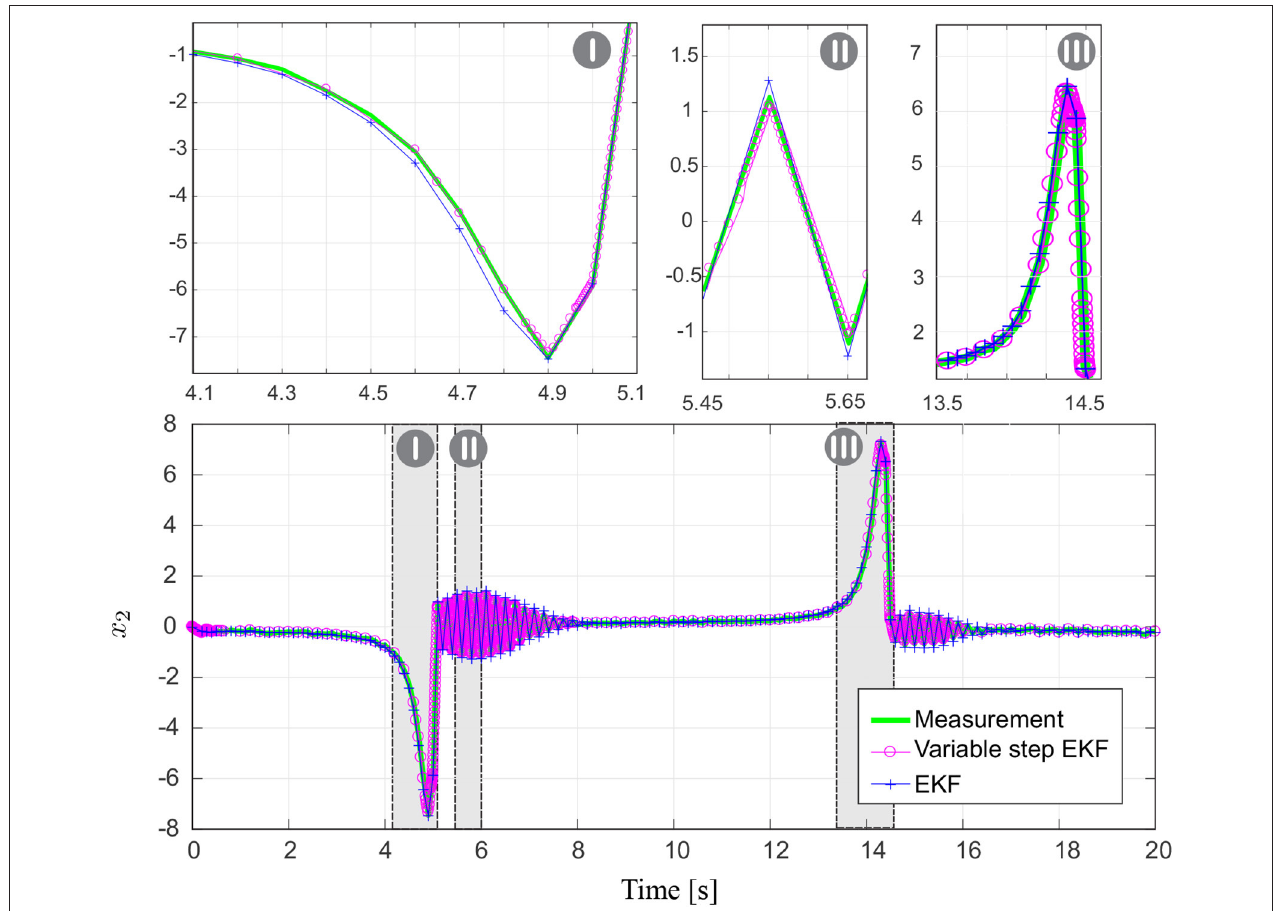
FIGURE 3 | Estimation of Van der Pol oscillator second state x 2 using fixed and variable step size Extended Kalman Filter.